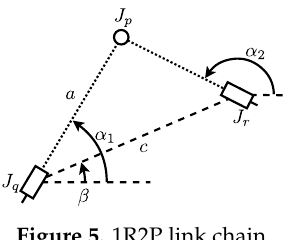
Figure 4. 2R1P link chain.